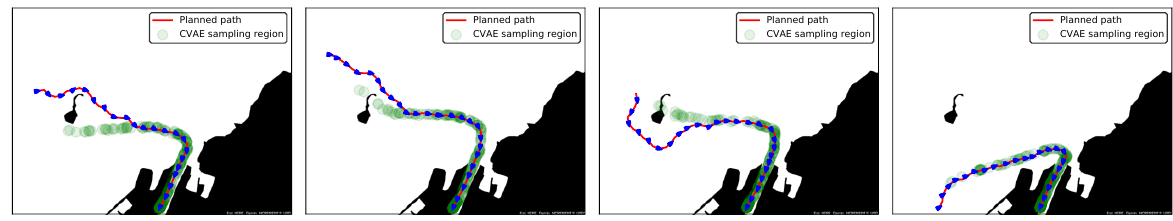
Figure 7: Examples of the path using RRT* with a learned CVAE sampler when the starting point is beyond human experience in the Trondheim harbour.